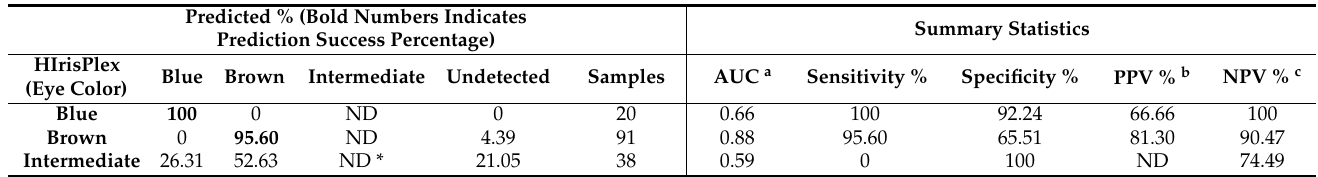
Table 1. The classification for each different eye color category and summary statistics (AUC, sensitivity, specificity, PPV, and NPV) using HIrisPlex for the Turkish population.